Question: What kind of plot is shown here?
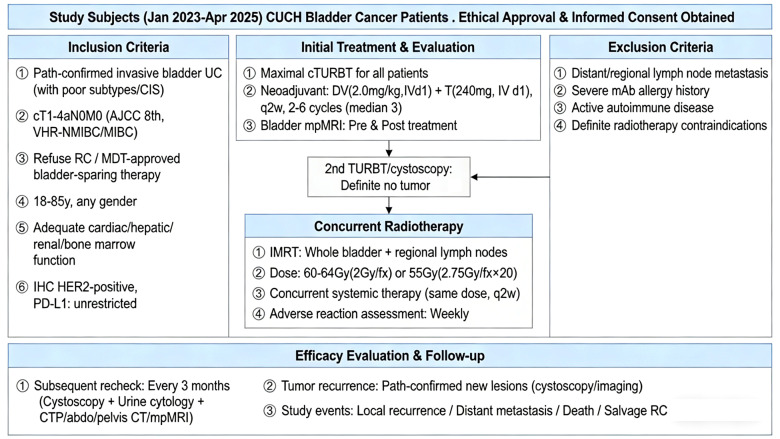
Answer: bar